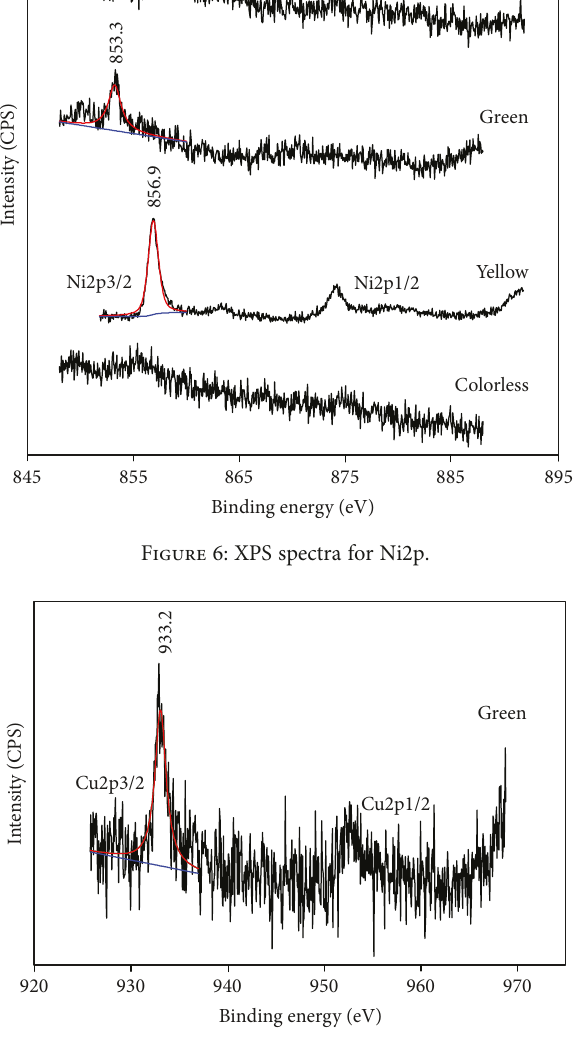
Figure 7: XPS spectrum for Cu2p.